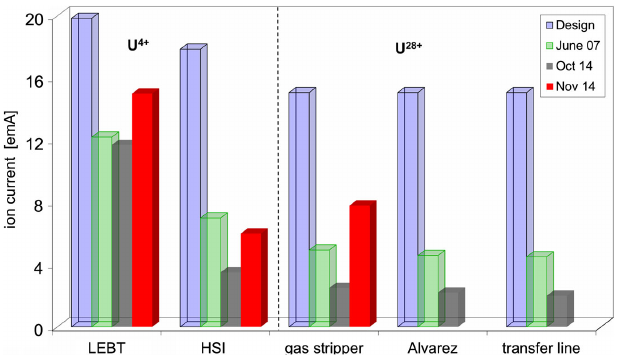
FIG. 10. Achievement of a new uranium beam ( 28 þ ) intensity record at GSI-HSI and gas stripper section. A newly developed extraction system was in use as well as the fast pulsed H 2 -gas stripper cell. The former U 28 þ -peak value (2007) was exceeded